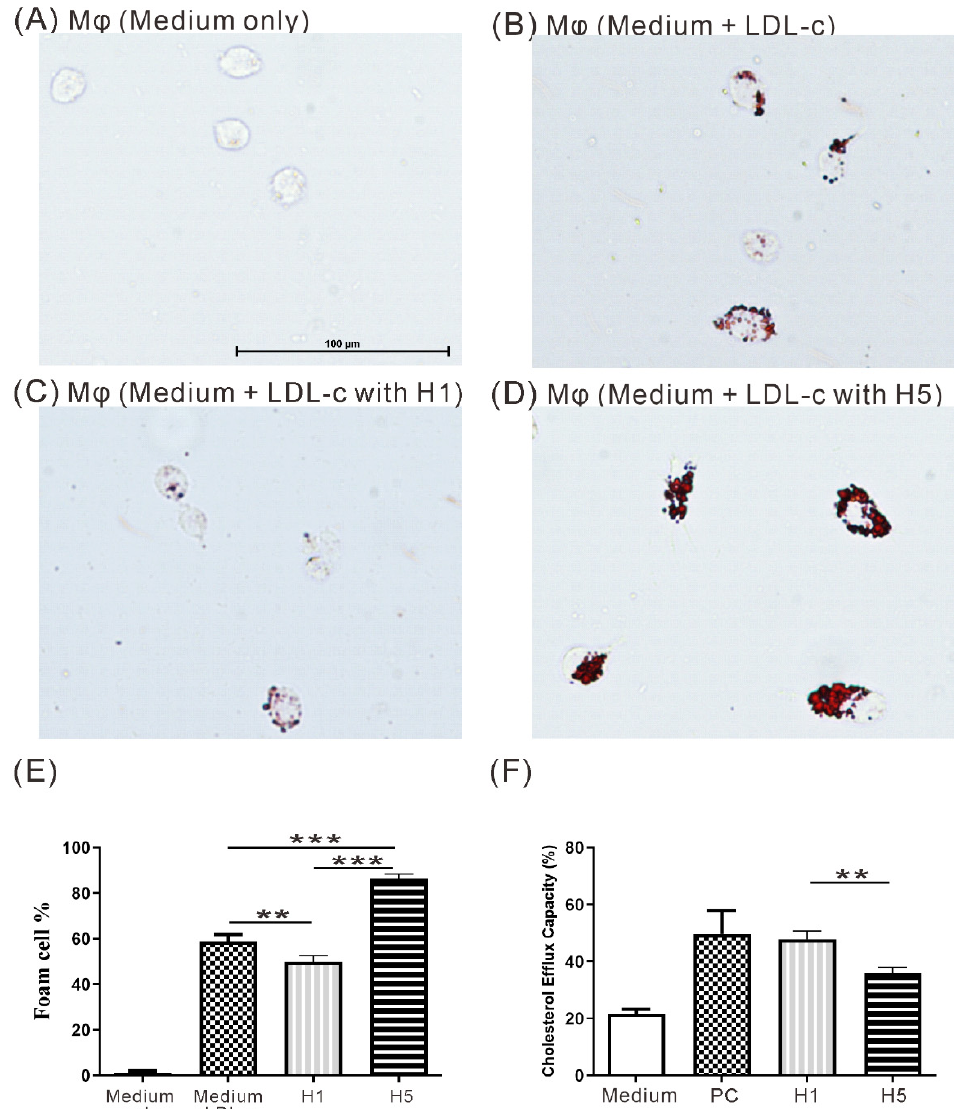
Figure 4. Effects of H5 on macrophage foam cell formation. THP-1-derived macrophages incubated with ( A ) culture medium only, ( B ) 50 µ g/mL LDL, ( C ) 50 µ g/mL LDL + 50 µ g/mL H1, and ( D ) 50 µ g/mL LDL + 50 µ g/mL H5. ( E ) Difference in the proportion of macrophage foam cell formation among the different groups. ** p < 0.005, *** p < 0.001, determined by using one-way ANOVA test followed by Turkey’s post-test. ( F ) The cholesterol efflux capacity assay of H1 and H5. PC: Positive control (as kit reagent). ** p < 0.005, determined by using Student’s t -test. 2.9. Comparison of Lp(a) Levels among Patients with High H5%, Patients with Normal H5%, and